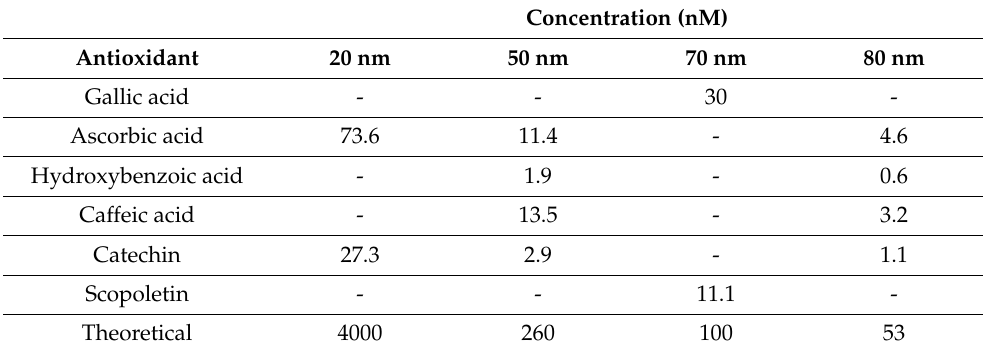
Table 1. Concentration (nM) of nanoparticles of different sizes (20, 50, 70 and 80 nm), synthesised by various antioxidants (gallic acid, ascorbic acid, hydroxybenzoic acid, caffeic acid, catechin and scopo- letin). The concentrations were calculated from Beer-Lambert’s Law (according to Paramelle et al. 2013). Theoretical: theoretical molar concentration, assuming the total conversion of silver ions into silver nanoparticles (according to Kalishwaralal et al. 2010). Concentration (nM) Antioxidant 20 nm 50 nm 70 nm 80 nm Gallic acid - - 30 - Ascorbic acid 73.6 11.4 - 4.6 Hydroxybenzoic acid - 1.9 - 0.6 Caffeic acid - 13.5 - 3.2 Catechin 27.3 2.9 - 1.1 Scopoletin - - 11.1 - Theoretical 4000 260 100